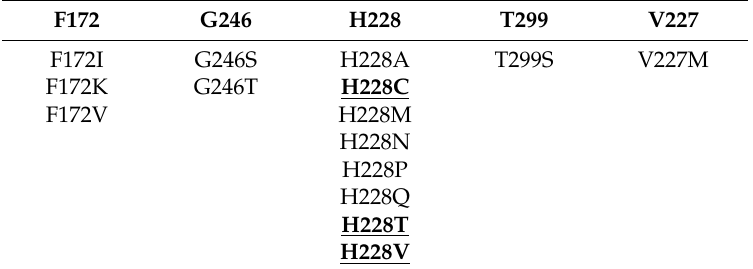
Table 4. Mutations proposed by the SSV method for the non-tolerant β -glucosidase, Bgl1B. Mutations underlined and in bold were found in the literature. F172 G246